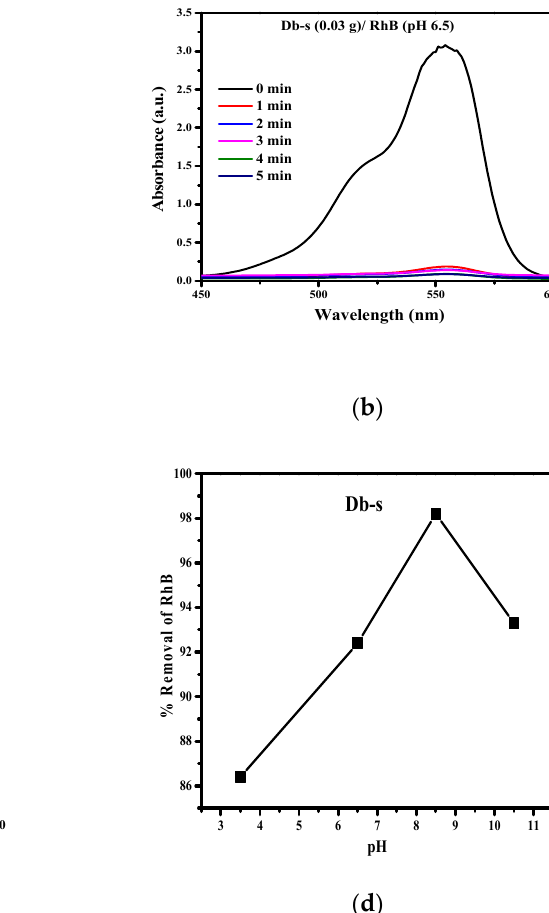
Figure 7. ( a ) Adsorption spectra of RhB during adsorption at pH 3.5 and at different times containing 0.03g of AC (Db-s). ( b ) Adsorption spectra of RhB during adsorption at pH 6.5 and at different times containing 0.030g of AC (Db-s). ( c ) Adsorption spectra of RhB during adsorption at pH 8.5 and at different times containing 0.03g of AC (Db-s). ( d ) Effect of pH on the removal of RhB by AC (Db-s).